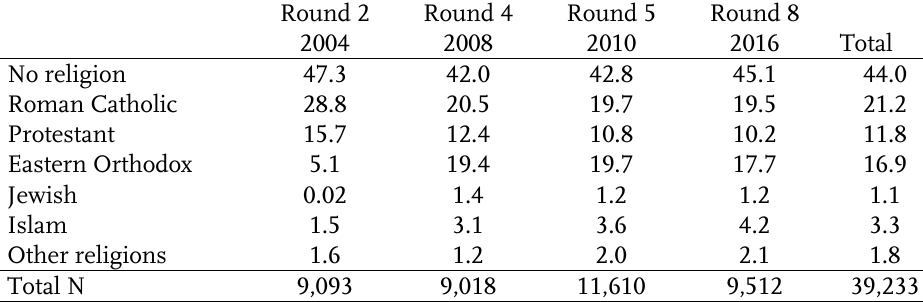
Table 2 : Share of religious groups across ESS